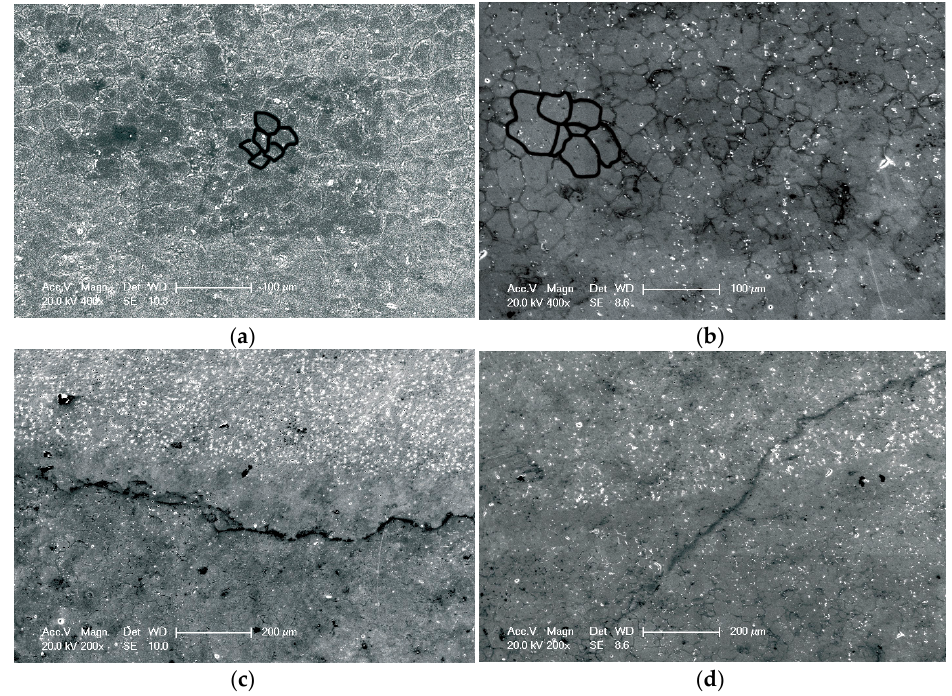
Figure 3. Typical observation in the top surfaces of the specimens with LSP assisted by DSA and the untreated specimens: ( a ) HAZ of the specimen with LSP assisted by DSA; ( b ) HAZ of the untreated specimen; ( c ) TMAZ-HAZ of the specimen with LSP assisted by DSA; ( d ) TMAZ-HAZ of the untreated specimen.